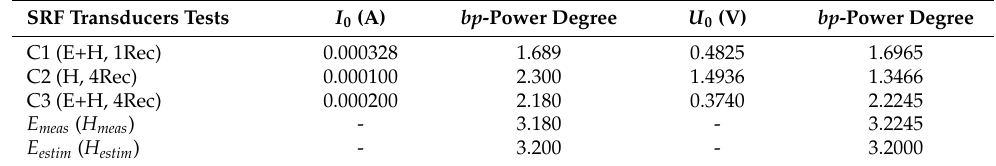
Figure 7. ( a ) Measured DC voltage only for a long RF coil (C2 configuration) and for both an RF coil and all pancake plates. ( b ) Transmitter and transducer plates at a 150 mm distance, producing 0.7 W to power 14 LEDs. Table 4. Voltage and current power regression coefficients, obtained from experimental